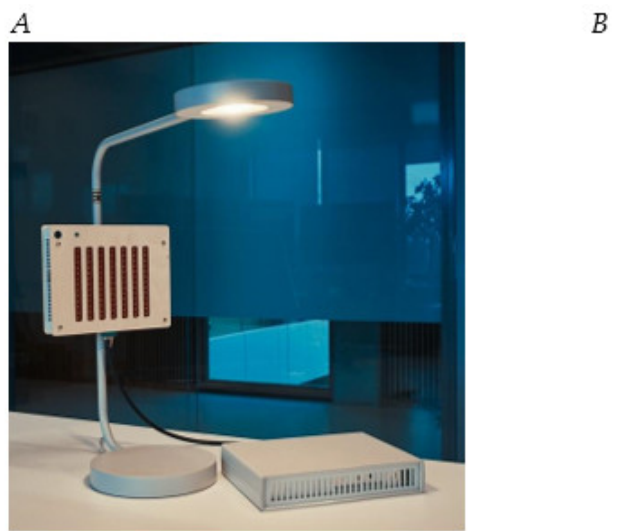
Figure 1. ( A ) PBM treatment module used in this study. The PBM module is incorporated in a desk lamp and its power is controlled by the driver at the table. The strips of low-power red LEDs at the front of the module were turned on in all conditions. The distance sensor (large circle) is shown. The smaller circle in the upper left corner is a green LED that provides feedback on the distance of the user. ( B ) A schematic overview of the different PBM dose durations all timed relative to the offset of the PBM session. Table 1. Dosimetry overview. # refers to ‘number of photons’.